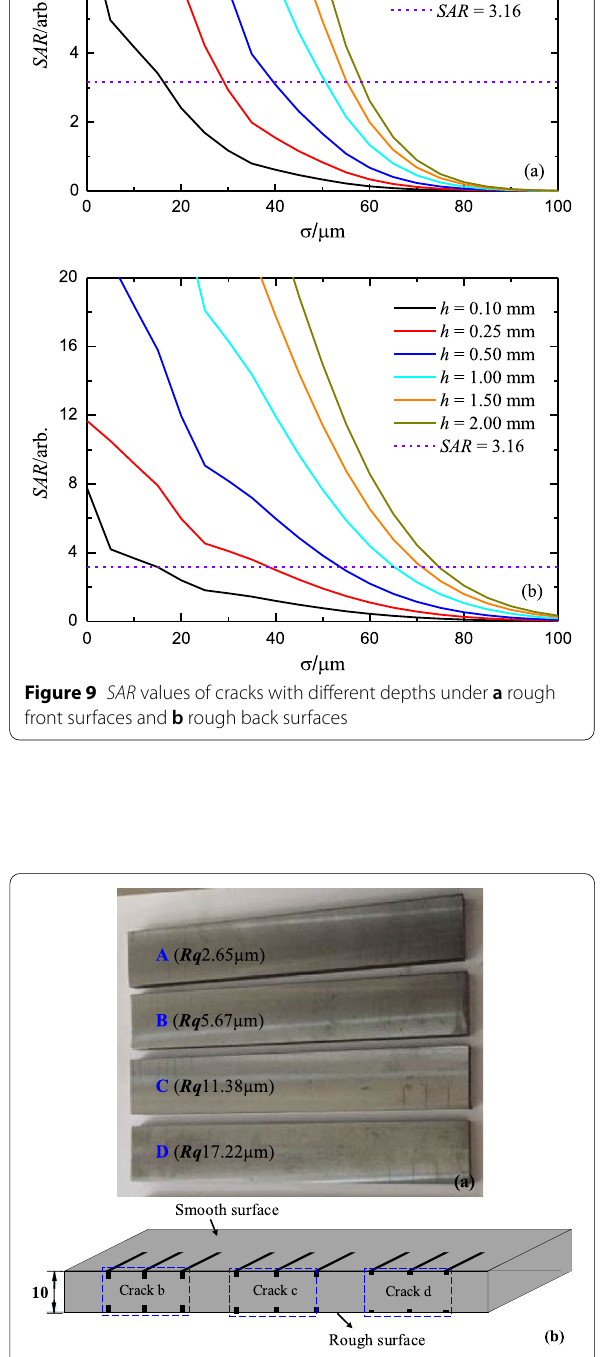
Figure 11 Time-domain signals of a micro-crack with 0.15 mm depth under different rough front